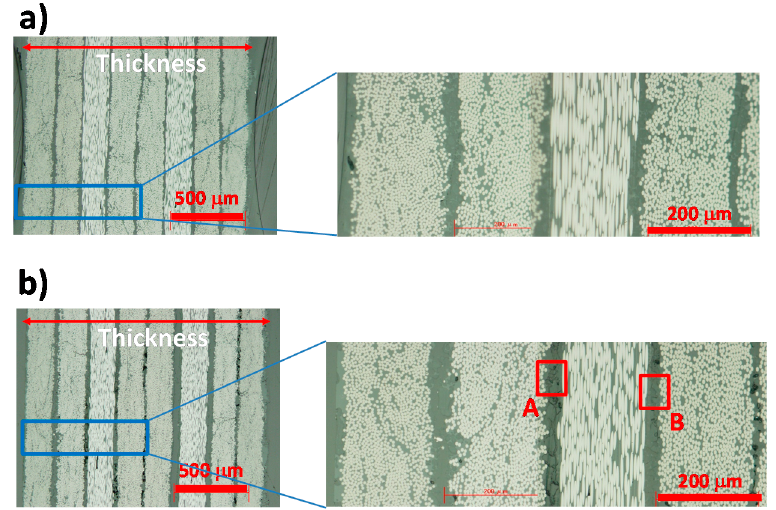
Figure 13. Optical microscopy images for ( a ) CFRP and ( b ) degraded CFRP (160 °C and 0.62 MPa (H 2 O vapor) in 14 days) samples. Expansion images at A and B areas are shown in Figure 14. Polymers 2016 , 8 , 242